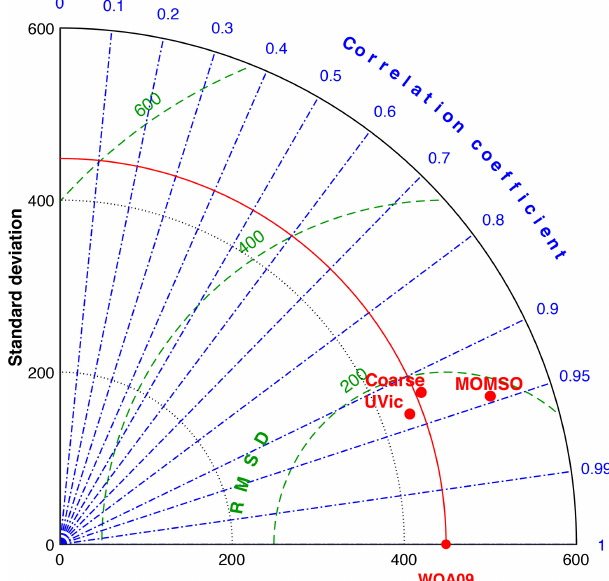
Figure 28. Taylor diagram of simulated phosphate concentration referenced to Southern Ocean WOA09 annual mean climatology (Garcia et al., 2010). The units for the standard deviation and root mean square deviations are µmolPm − 3 . “Coarse” refers to the very similar albeit coarser, non-eddying reference configuration used in Dietze et al. (2017) and “UVic” refers to the non-eddying Earth system model used, e.g., in climate engineering assessments (cf. reference version in Löptien and Dietze, 2019; Keller et al.,